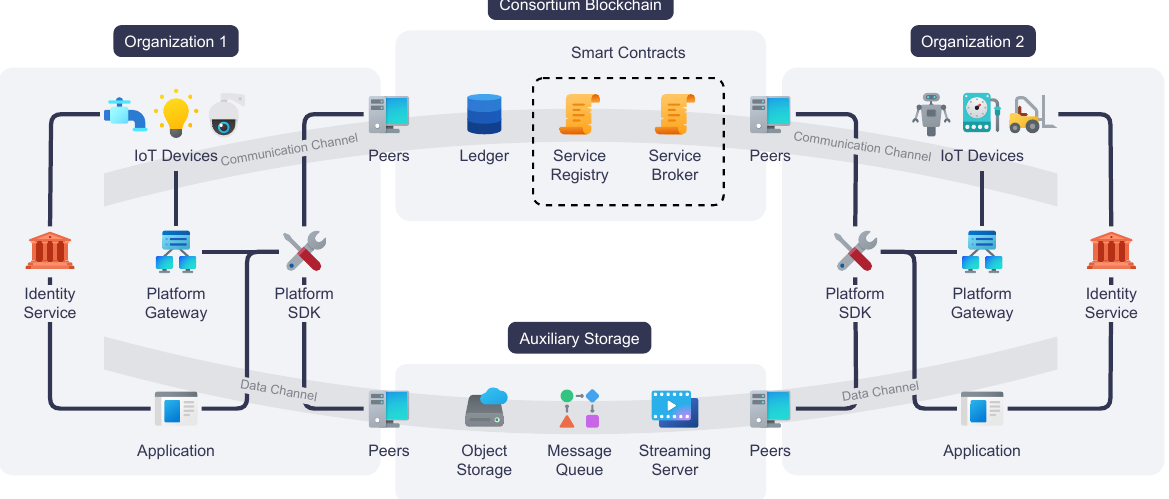
Figure 1. Consortium blockchain-based IoT service platform